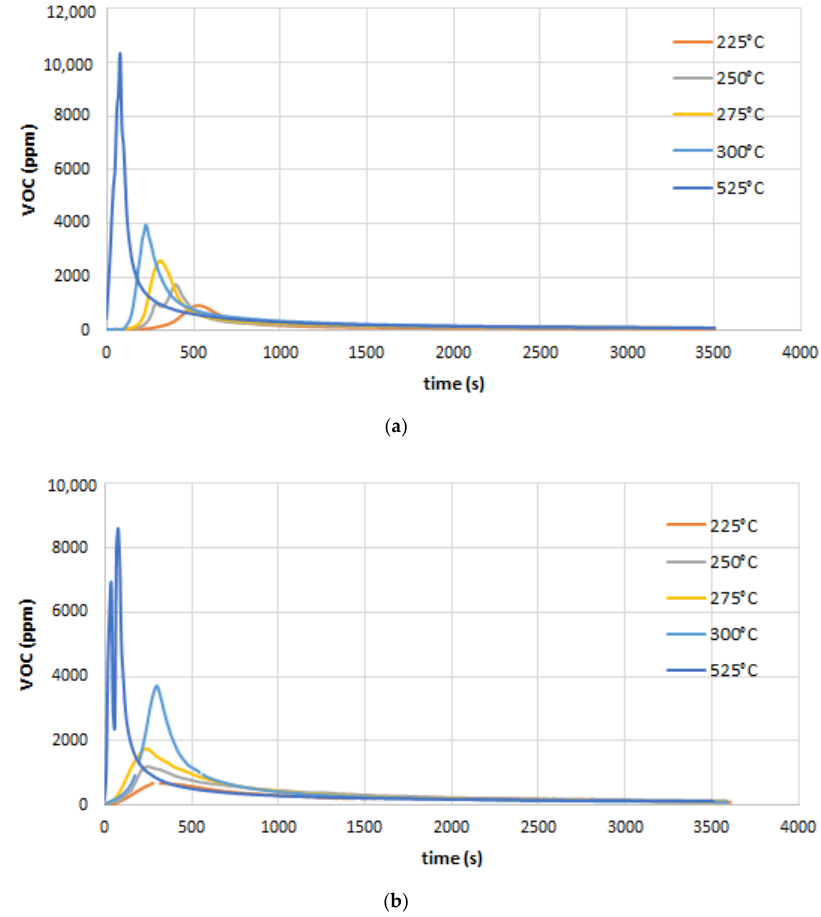
Figure 20. ( a ) VOC emission in ppm of maize straw during torrefaction process in electrical furnace in CO 2 atmosphere. ( b ) VOC emission in ppm of oat straw during torrefaction process in electrical furnace in CO 2 atmosphere.